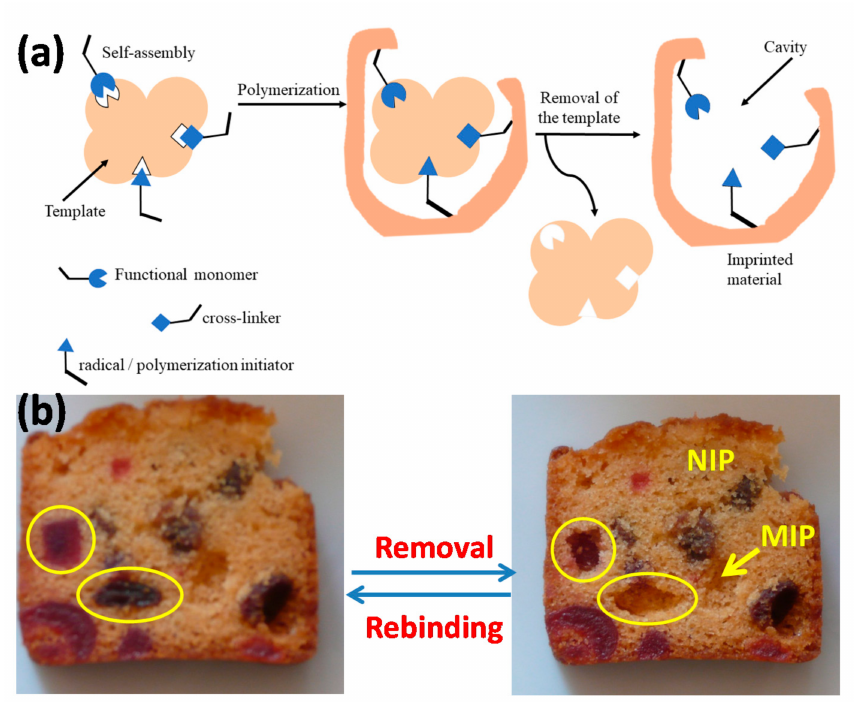
Figure 1. Principle of making MIPs ( a ), and illustration of the imprinting technique by digital photographs of a slice of cake before after removal of candied fruits ( b ). NIP: non-imprinted polymer. Imprinted organic and sol-gel polymers can be prepared using a large variety of monomers, the choice depending on the application (Table